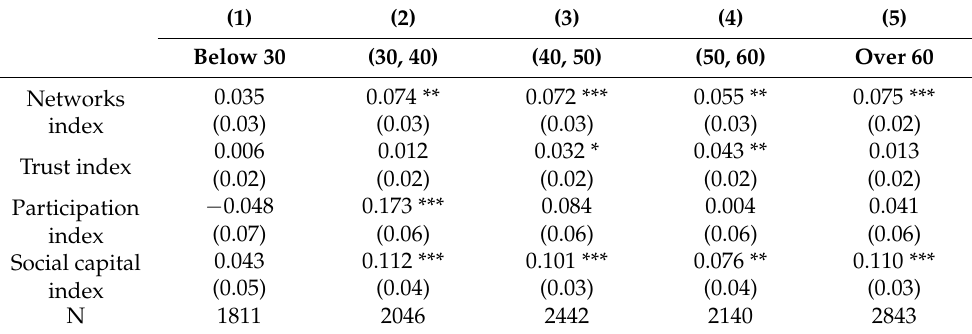
Table 9. The heterogeneous effects of social capital on waste-separation behavior.